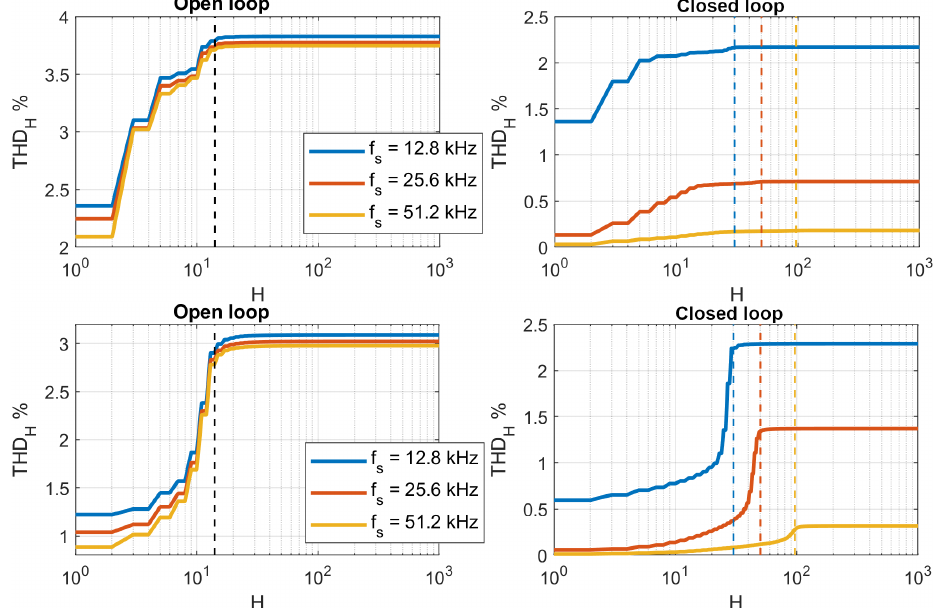
Figure 23. THD H as a function of H . Top row—rectifier load, bottom row—abruptly changing resistive load.Vertical colored dashed lines indicate resonant frequencies f r for no-load closed-loop systems from Table 2 depicted in Figure 15, and black line for f r = 702.81 Hz for the open-loop system depicted in Figure